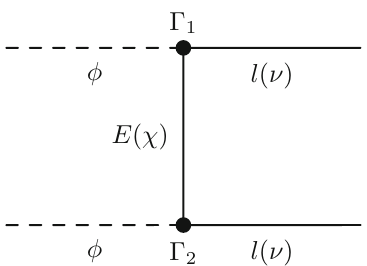
Fig. 2 General diagram contributing to the relic density